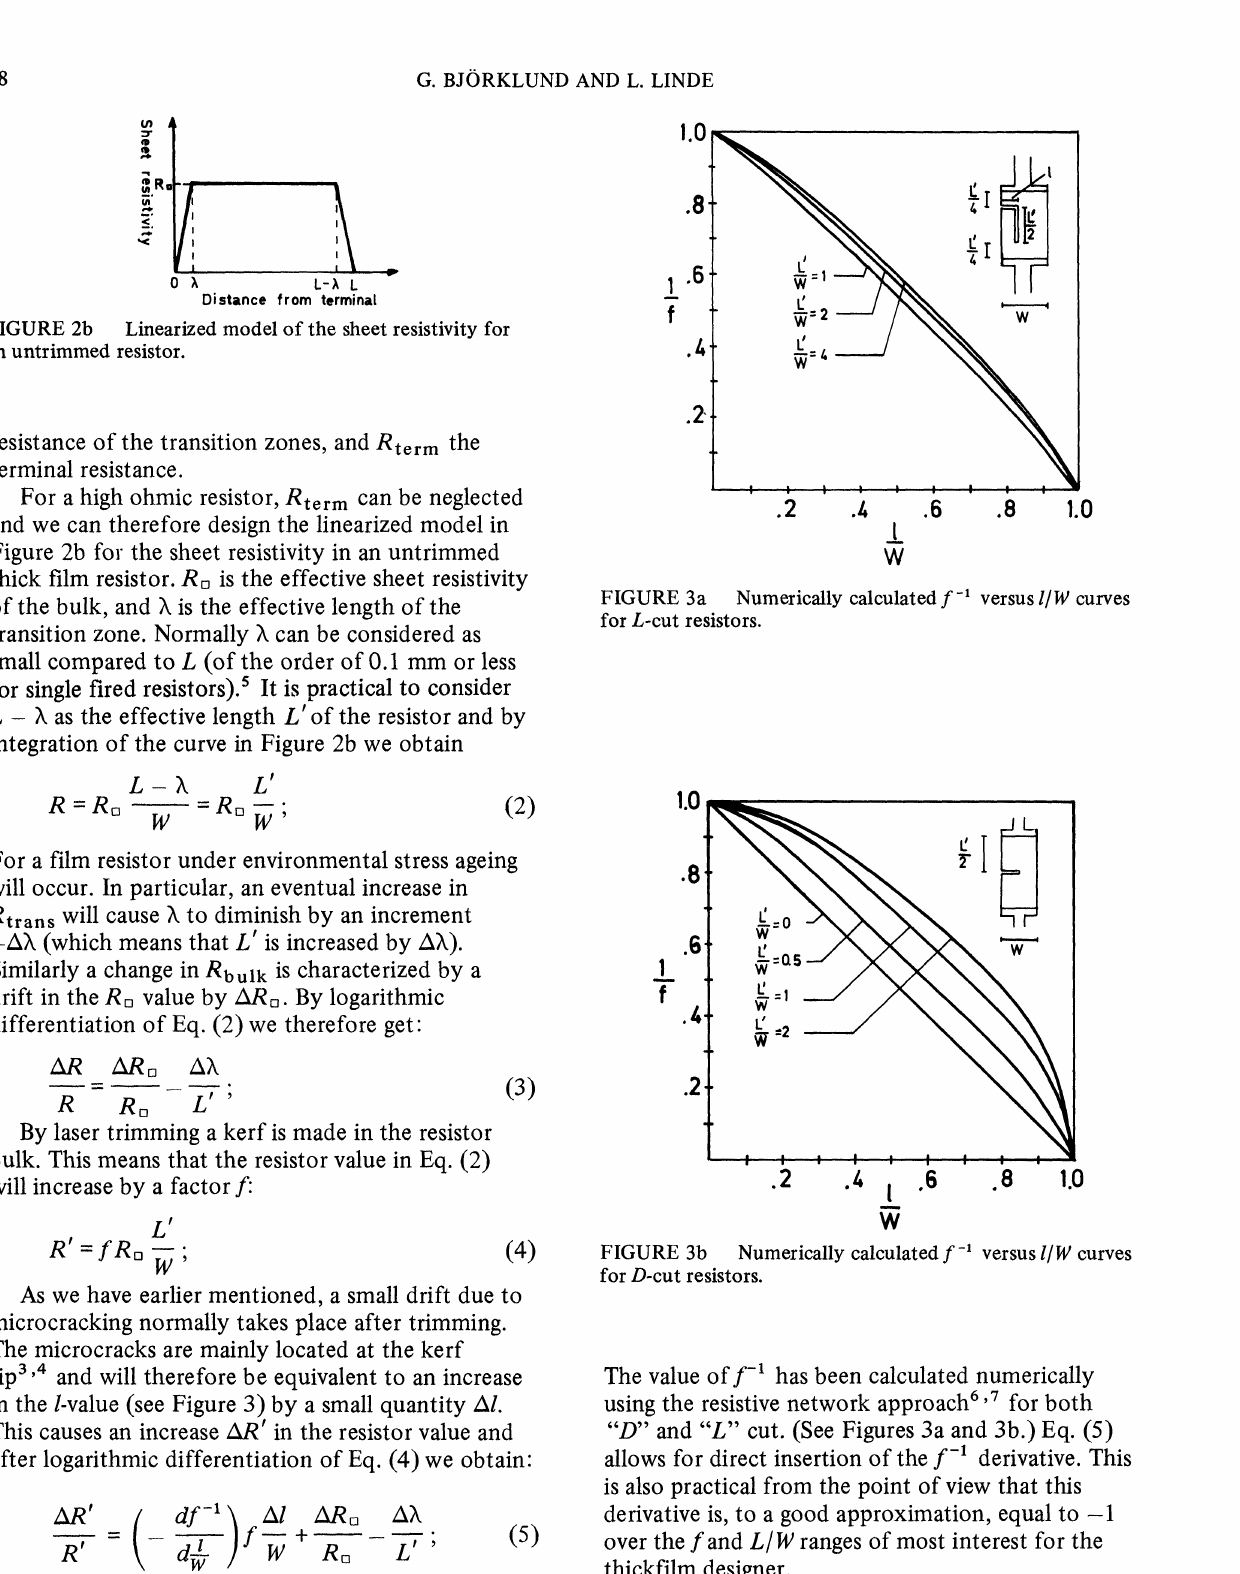
FIGURE 2b Linearized model of the sheet resistivity for an untrimmed resistor.